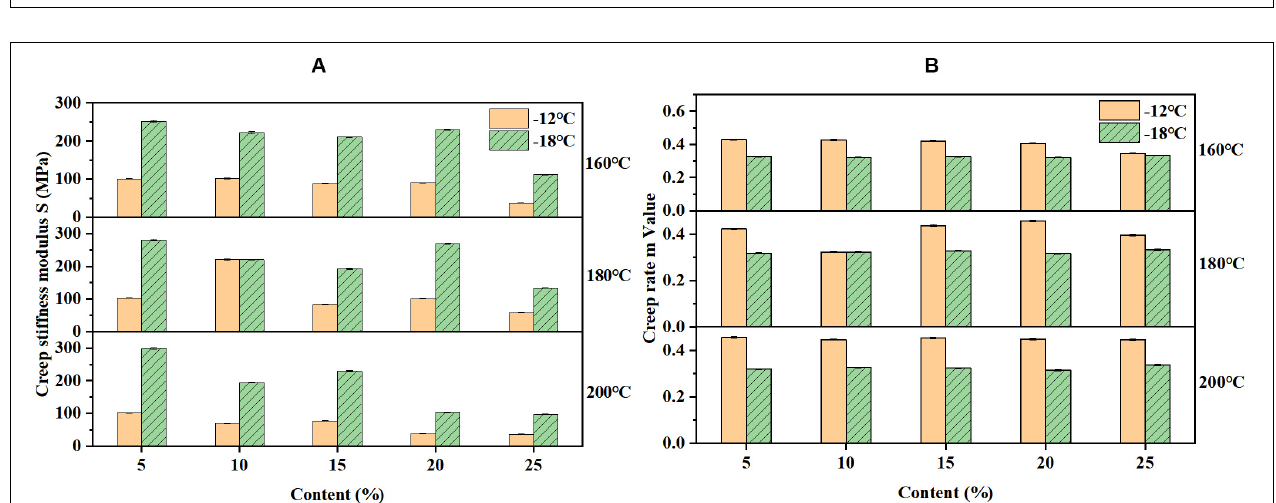
FIGURE 8 | Creep stiffness and m -value of TB- C. (A) Creep stiffness of TB-C. (B) m -value of TB- C.